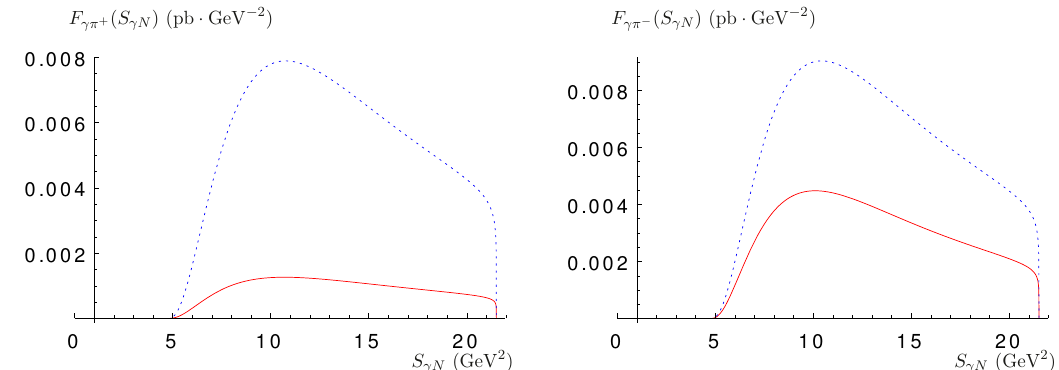
Figure 8 . Shape of the integrand of σ eN , as a function of the invariant mass of the hadronic pro- duced state, on a proton target. Left: γπ + production on a proton target. Right: γπ − production on a neutron target. In solid-red: “valence”. In dotted-blue: